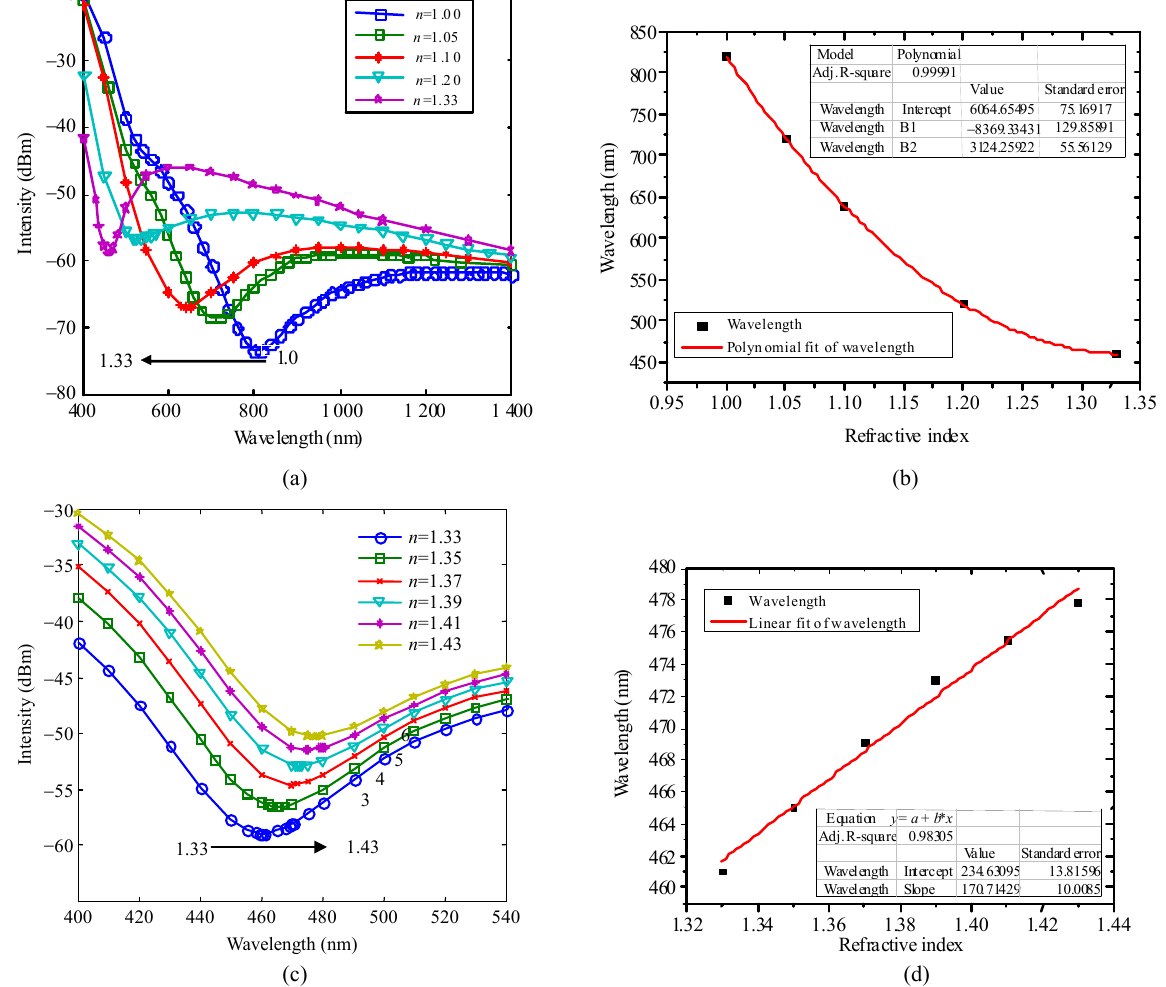
Fig. 6 SPR spectra with analyte RI variation: (a) from 1.0 to 1.33, (c) from 1.33 to 1.43, and (b) and (d) the relationship between resonant wavelength and analyte